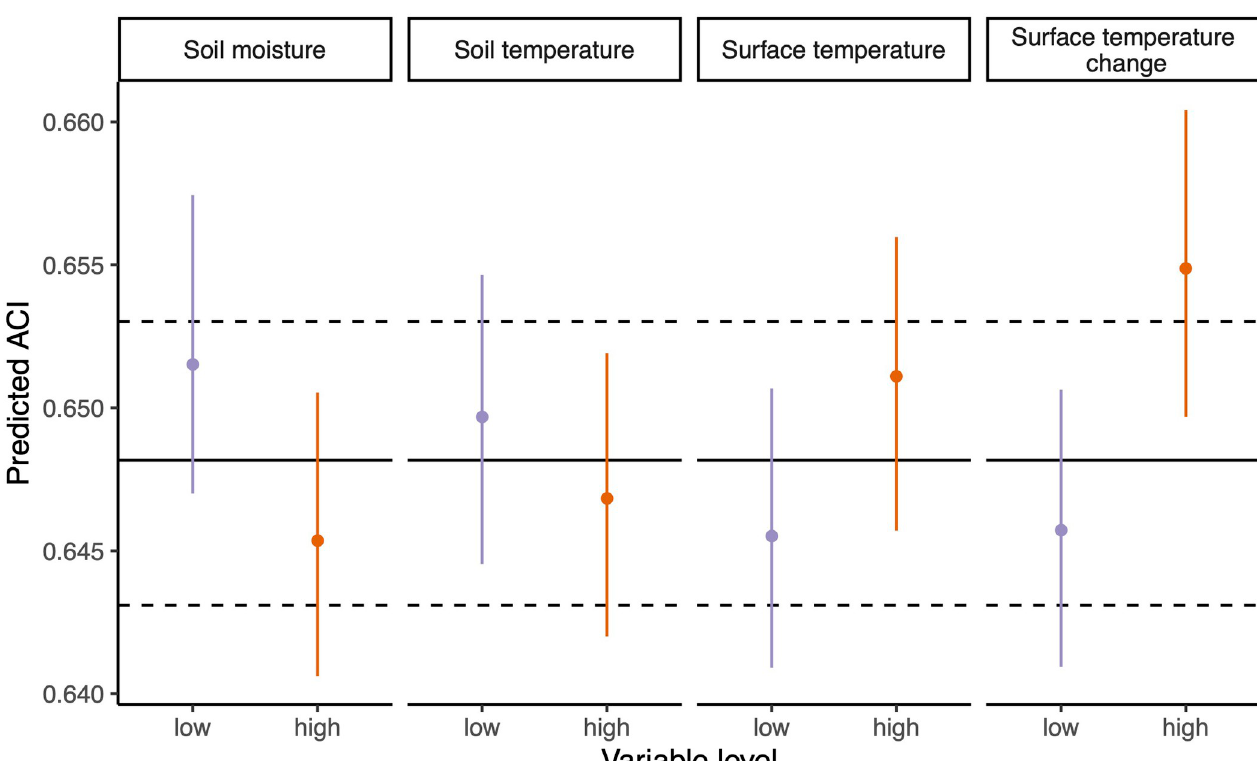
Fig 5. Predicted values from hierarchical models analyzing the effect of microclimate on ACI. Four microclimate variables were included in the models. Surface temperature change denotes the positive temperature change 30 min prior to the ACI measurement. For each variable, predictions are shown for a scenario at a low level (mean–1SD) and at a high level (mean + 1SD). For surface temperature change, the low-level scenario was set to 0 degrees temperature change to keep scenarios realistic. For soil moisture, a quadratic term was included in the model to account for a potential non-linear effect. Points show the highest maximum a posteriori estimates, and error bars show the 95% highest density intervals. Lines in black show the global mean, with its 95% highest density interval.